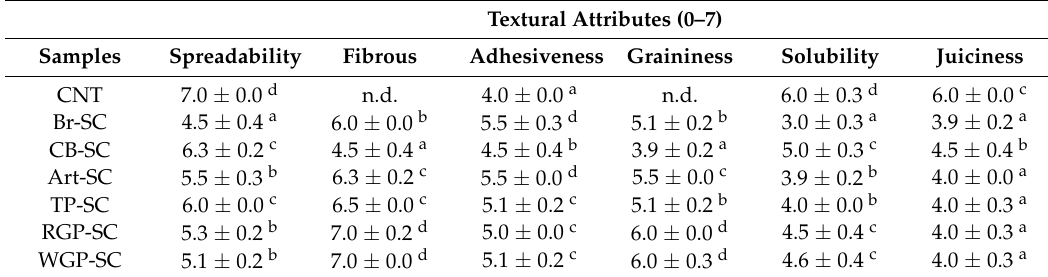
Table 4. Rating for textural attributes of spreadable cheeses